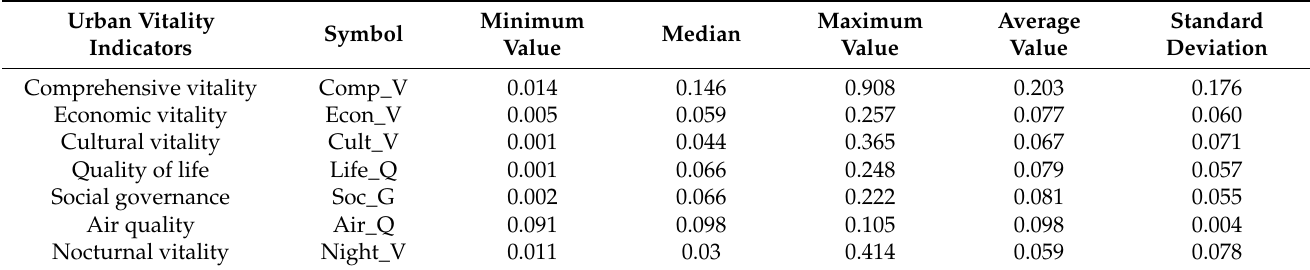
Table 4. Descriptive statistics of the urban vitality indicators.